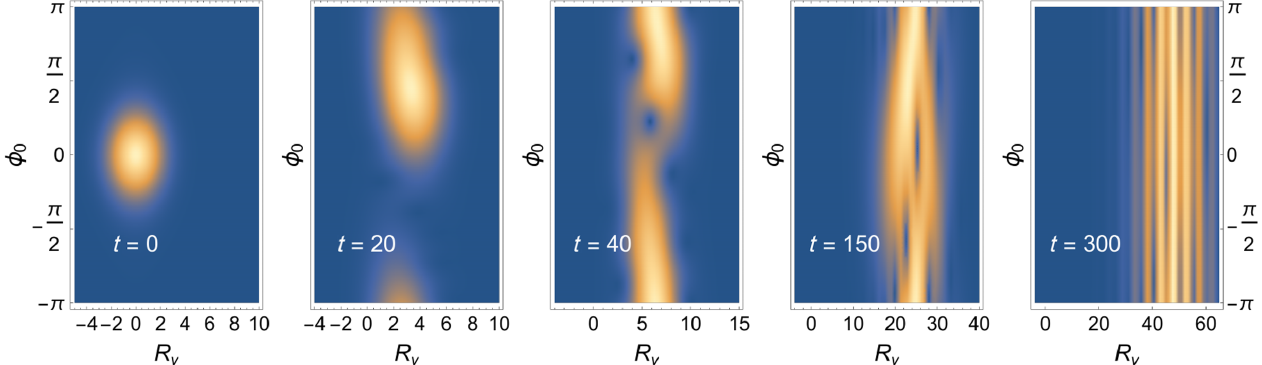
FIG. 6. Snapshots of the probability distribution j ψ ð ϕ 0 ; R y Þj 2 of the helicity ϕ 0 and the y coordinate of the quantum-mechanical wave function, for times t ¼ 0 , 20, 40, 150, 300, of an antiskyrmion driven by a magnetic field gradient (initial condition ffiffiffiffiffiffi p ; ϕ ∼ e − sin 2 ð ϕ 0 = 2 Þ = δϕ 2 e − R 2 y B d = 4 , with width δϕ ¼ ð π = 8 Þ , M=B 10 , Θ ¼ 20 , F= B ψ ð R ¼ 0 . 025 , κ ¼ κ 0 ¼ 0 . 1 , N 0 f ¼ y 0 Þ d ¼ d κ Θ = 2 M Þ ). For short times the angle ϕ − ð B d 0 grows linearly in time, but its wave function also spreads. For long times, the wave function splits into distinct wave packets. This does not reflect an interference effect but arises because the velocity depends on the number of flipped spins N f [see Eq. (16)]. It therefore indicates a perfect entanglement of position and N f . For a skyrmion the same result is obtained with R y → − R y